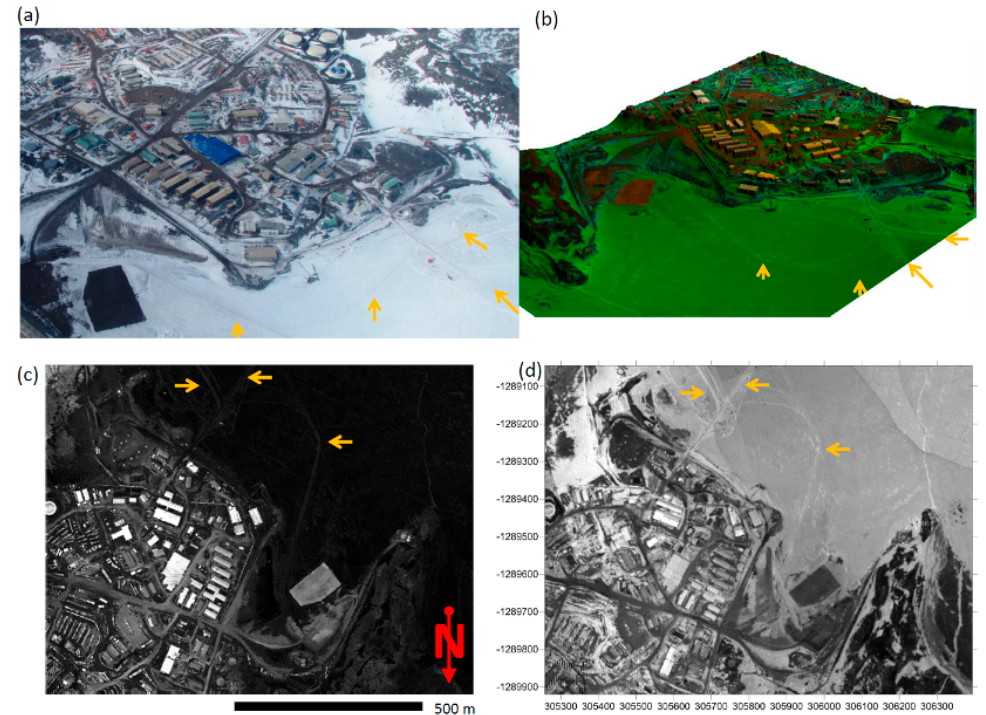
Figure 7. Potential spectral separability of loose and compacted snow, roads with compacted ice and snow are marked with yellow arrows in the figures. ( a ) Aerial oblique image of McMurdo Station at the time of lidar data collection; ( b ) Perspective view of a 3D surface model overlaid with a false color lidar intensity image; ( c ) Active intensity image generated from the 1550 nm channel; ( d ) Active intensity image generated from the 1064 nm channel.